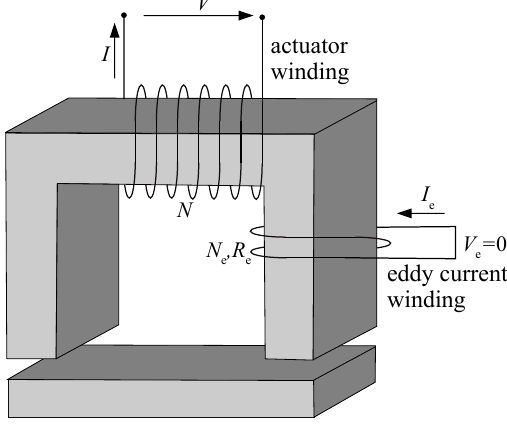
Figure 2. Actuator and eddy current